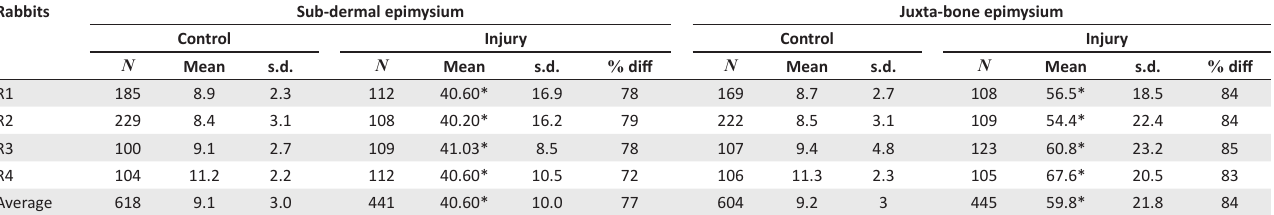
FIGURE 3: Phosphotungstic haematoxylin–stained section from sub-dermal biopsy showing thickened epimysium with fibroblasts and numerous mono- nucleate cells migrating into the muscle body (yellow TABLE 1: Cross-sectional measurement of the epimysium from sub-dermal and juxta-bone biopsies from control and injured muscle from Rabbits 1–4 expressed as mean and one standard deviation. Rabbits Sub-dermal epimysium Juxta-bone epimysium Control